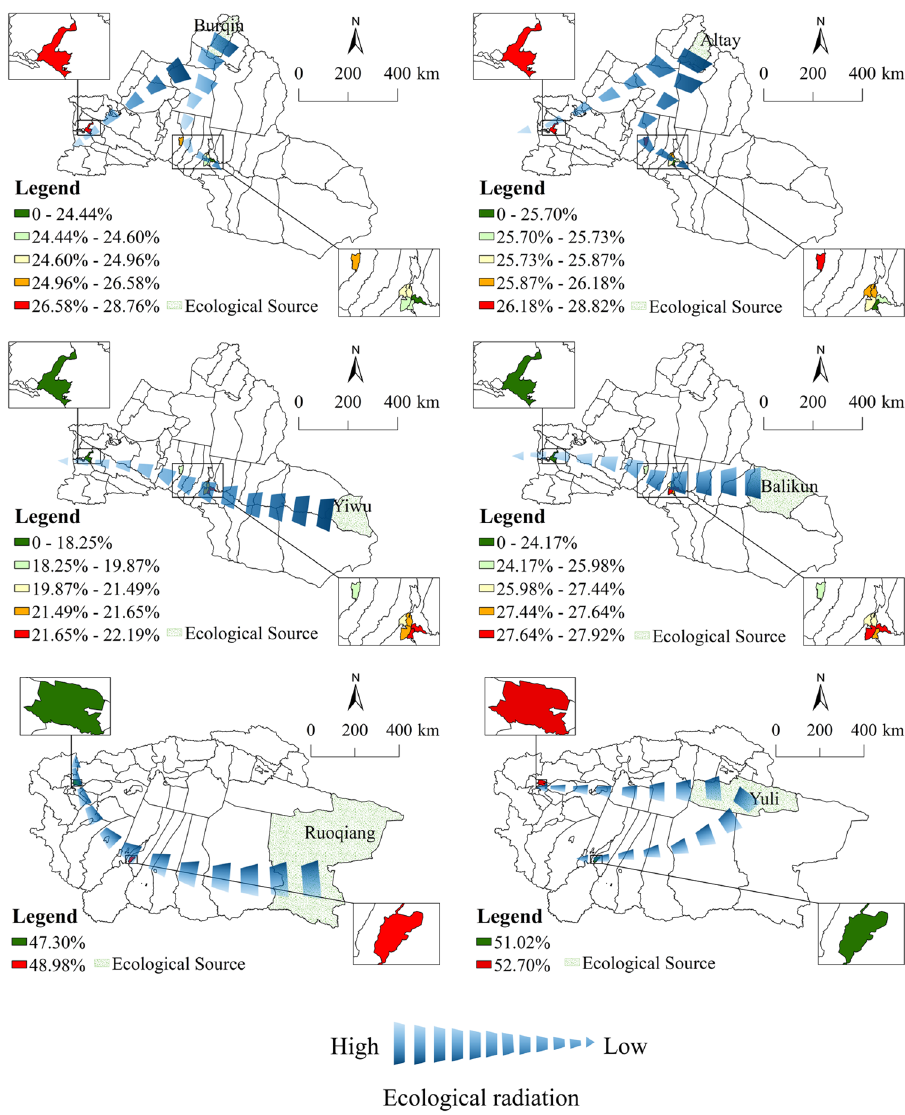
Figure 11. The proportion of ecosystem services provided by different ecological sources to the total amount received by the county. Map generated with ArcGIS 10.8 (ESRI). URL: https:// suppo rt. esri. com/ en/ Produ cts/ Deskt op/ arcgis- deskt op/